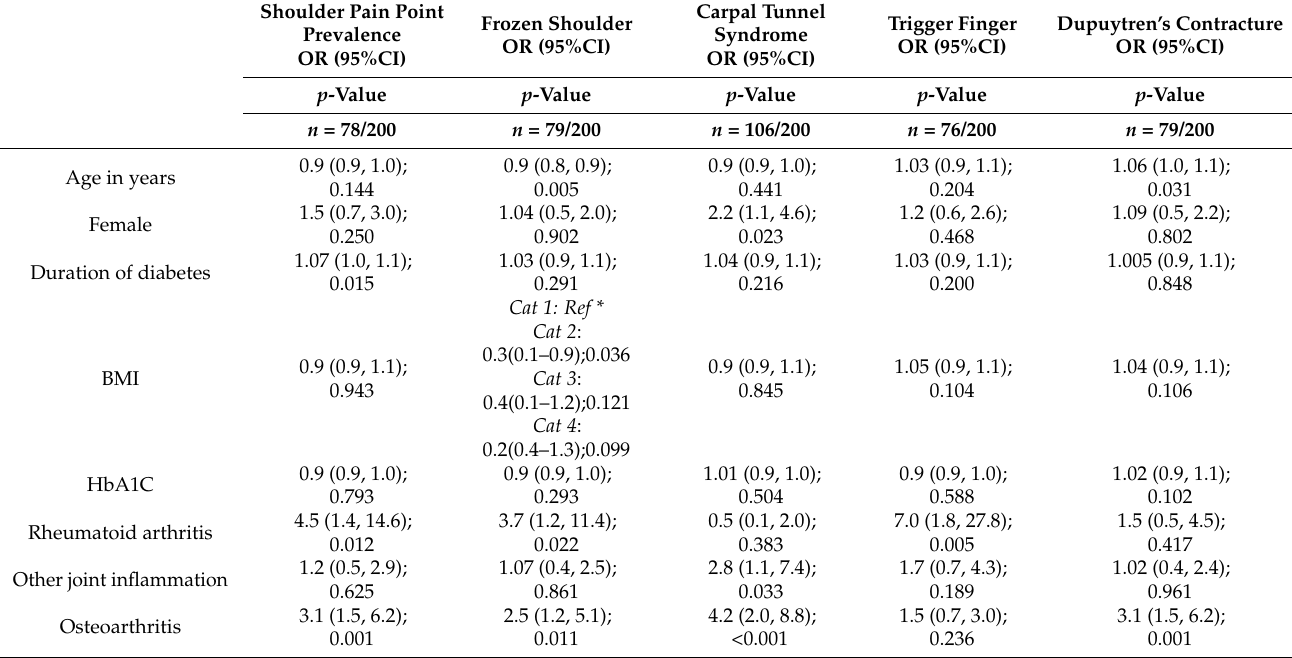
Table 5. Multivariable logistic regression analysis of specific upper extremity musculoskeletal disorders on complaint or diagnosis level in patients with type 2 diabetes in the questionnaire